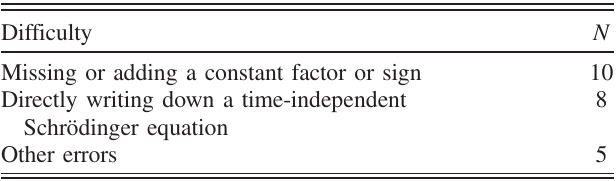
TABLE V. Difficulties in step C1: setting up a basic equation for the energy eigenfunction problem. Difficulty N Missing or adding a constant factor or sign 10 Directly writing down a time-independent